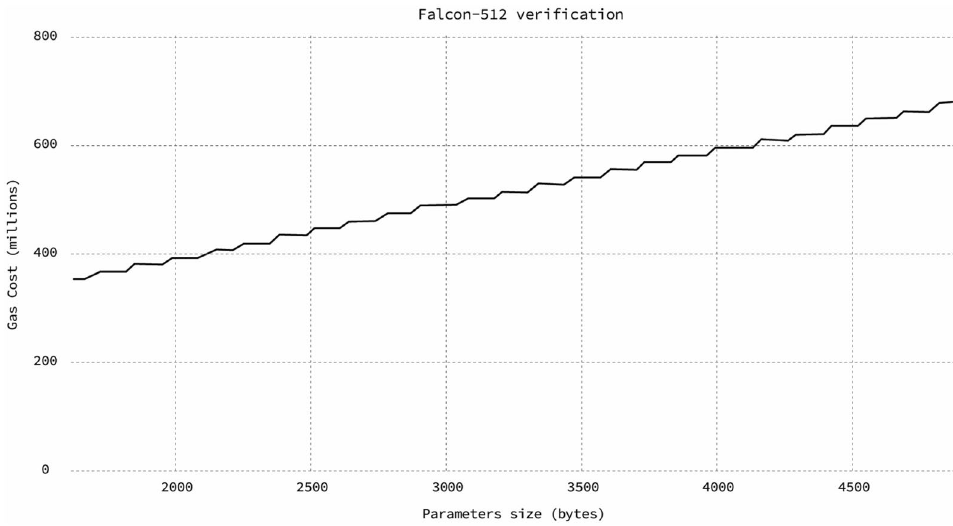
Figure 10. Gas consumption by the on-chain verification of Falcon-512 using the Solidity smart contract.